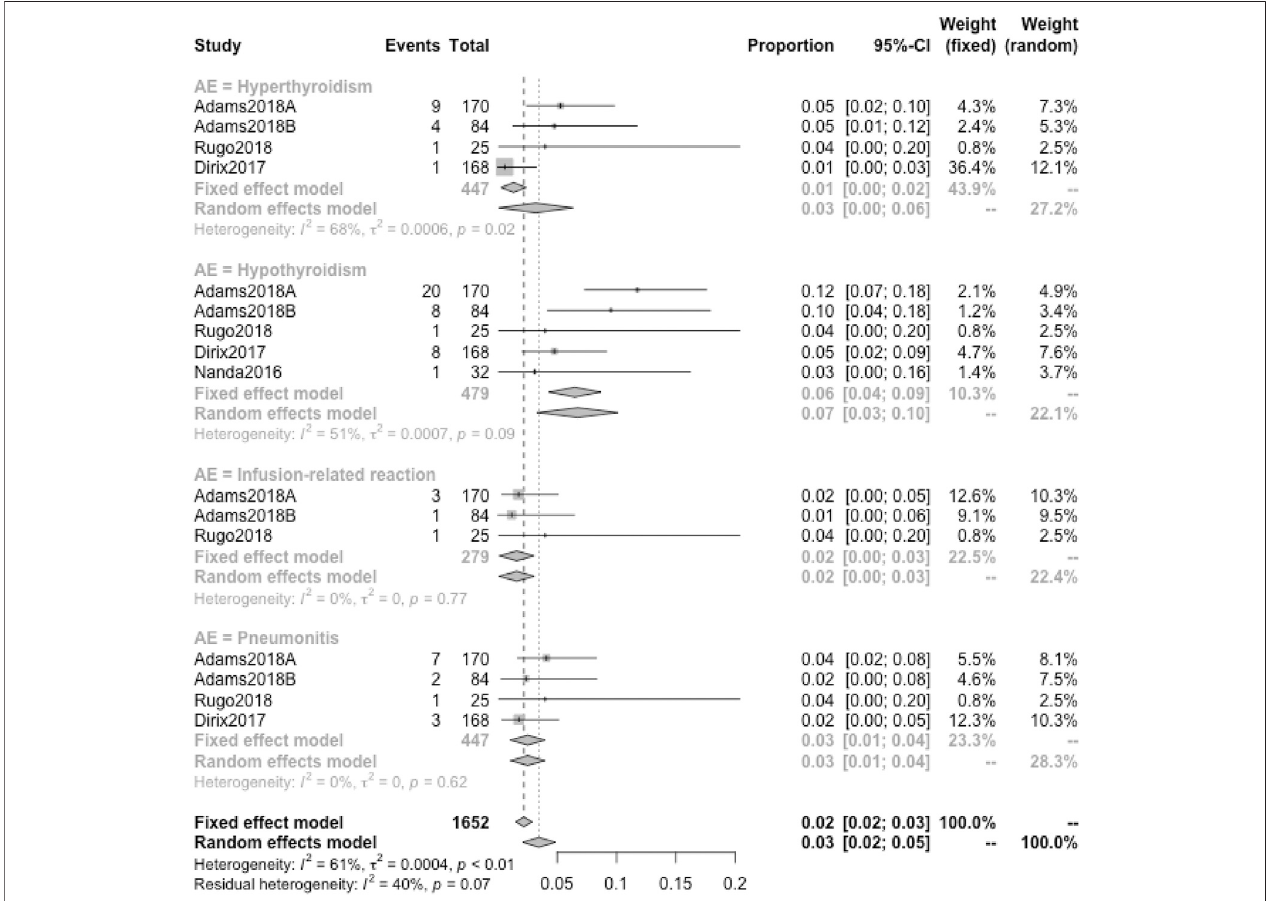
FIGURE 7 | Detailed incidence of immune-related AEs in any grade. The primary irAEs were hypothyroidism (7%), hyperthyroidism (3%), and pneumonitis (3%) followed by infusion-related reactions (2%).